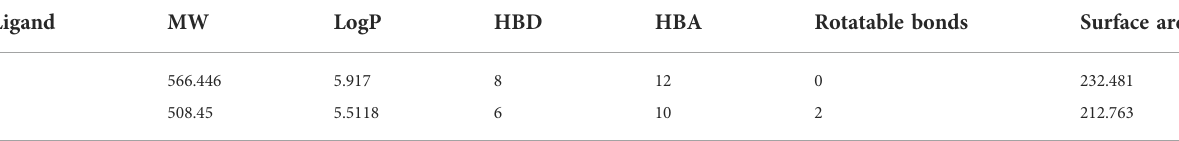
The red colour indicates that the ligand does not meet the criteria of the corresponding parameter.